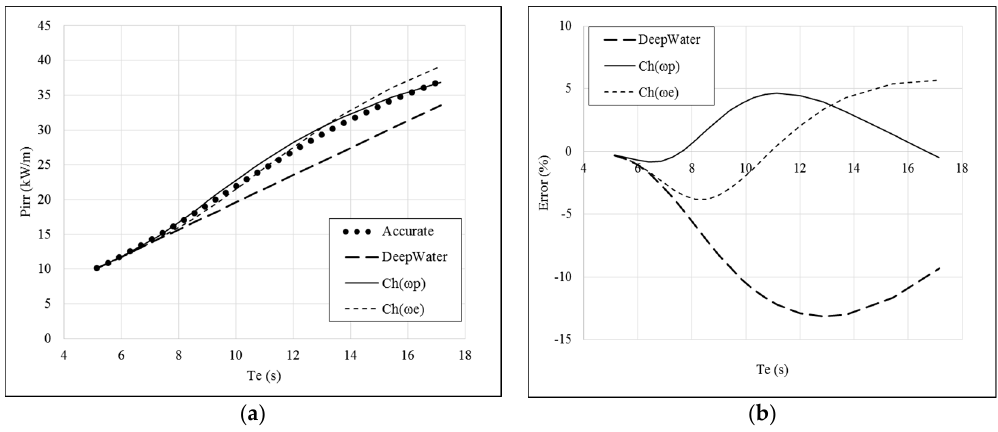
Figure 3. Comparison of the calculated wave power and the corresponding error by zero-order modifications against the accurate calculation and the deepwater condition (Case: h = 25 m, T p = 10 s). ( a ) Calculated wave power; ( b ) Error.